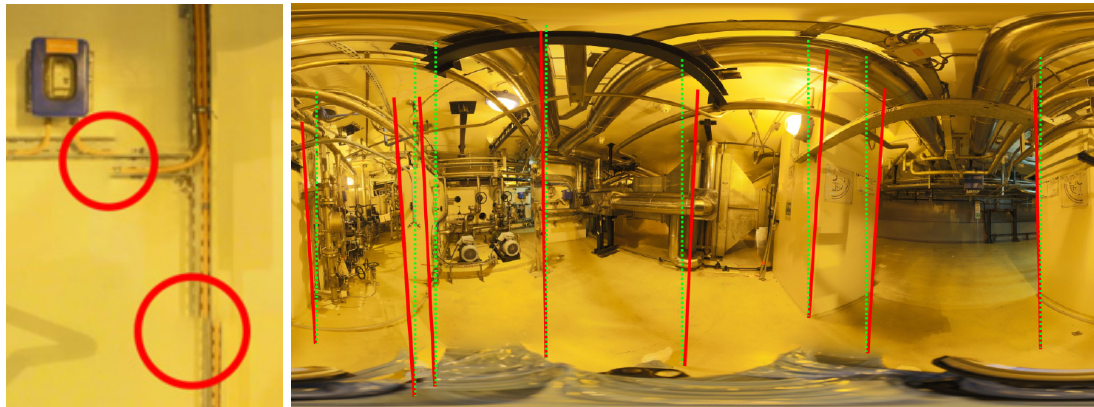
Figure 8. Typical issues in panoramic images. A lack of texture can lead to glitches in the final image ( Left ). The estimated vertical may have to be refined manually because horizon estimation algorithms can fail up to 15° ( Right ).